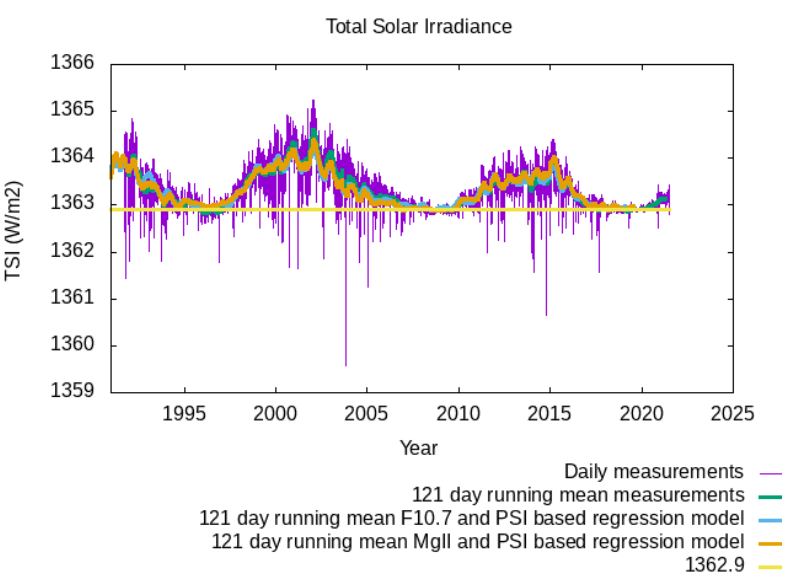
Figure 2. Purple curve: daily mean composite TSI values. Green curve: 121 day running mean composite TSI values. Light blue curve: 121 day running mean of TSI regression model based on F10.7 radio flux and Photometric Sunspot Index (PSI). Orange curve: 121 day running mean of TSI regression model based on MgII core to wing ratio and PSI.